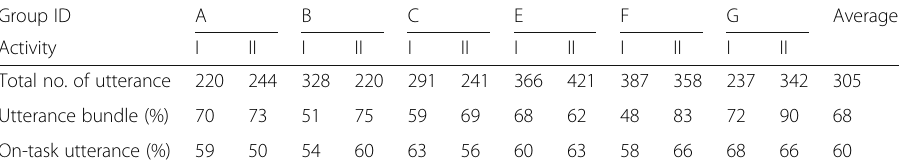
Table 2 Small group aidalogue patterns Group ID